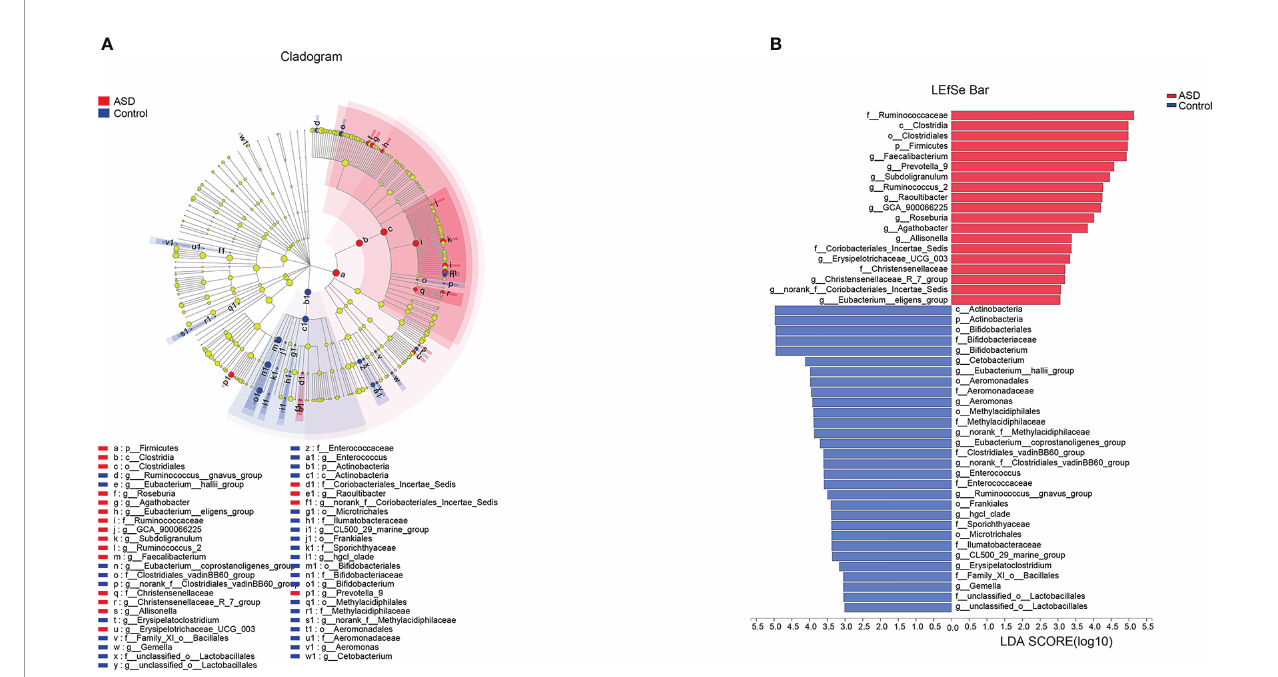
FIGURE 6 | LEfSe was applied to assess the effect size of each differentially abundant taxon. LDA were performed to identify the most differentially abundant taxa. (A) Cladogram using results of the linear discriminant analysis (LDA) model on the bacterial hierarchy and (B) LDA coupled with effect size measurements identi fi ed the differentially abundant taxa between the two